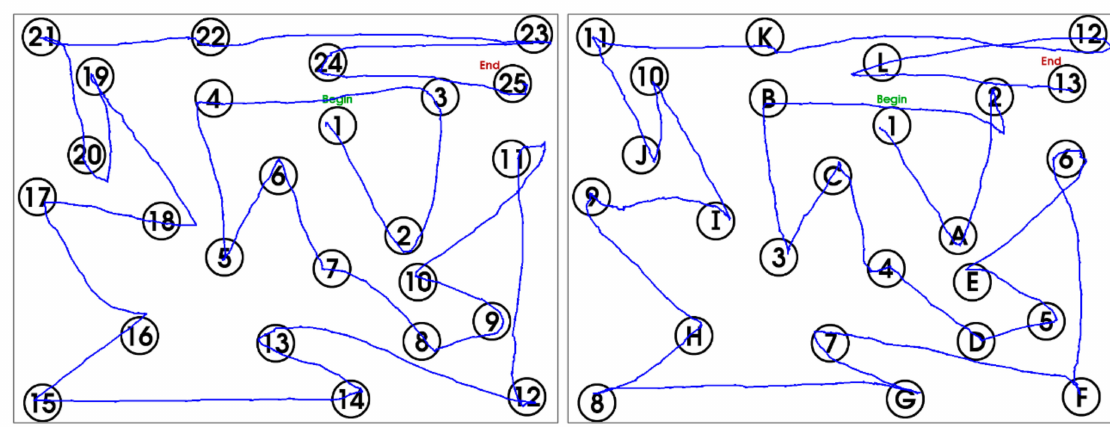
Figure 5. Example of tablet prototype 2 TMT behavioural performance. Left: TMT-A. Right: TMT-B. TMT = Trail Making